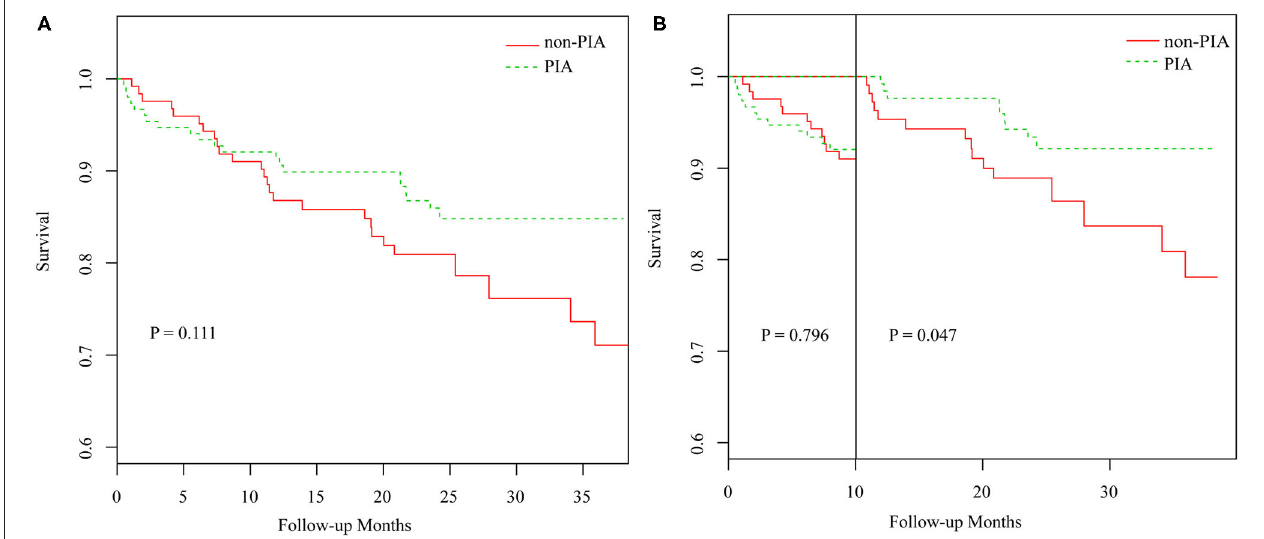
FIGURE 4 | The Kaplan-Meier curves of cumulative MACE-free survival probability. (A) Kaplan-Meier curve of PIA and non-PIA group, (B) Landmark analysis for the survival rate of PIA and non-PIA group. MACE, major adverse cardiac events; PIA, preinfarction